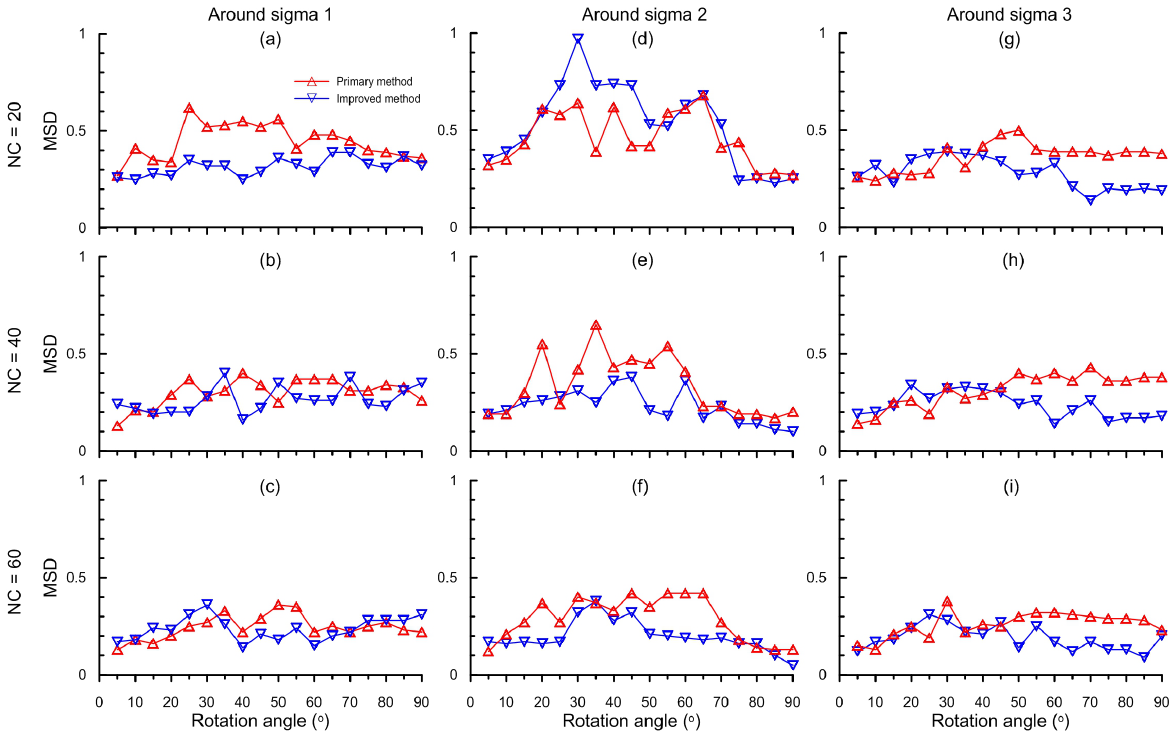
Figure 4. Variation of the maximum stress difference (MSD) between the imposed and estimated stresses with the rotation angle in the case of rotation around ( a – c ) σ 1 , ( d – f ) σ 2 , and ( g – i ) σ 3 , respectively. Both the primary method and the improved method are applied to a series of artificial two-phase e-twin datasets having 20, 40 or 60 twinned calcite crystals (NC).